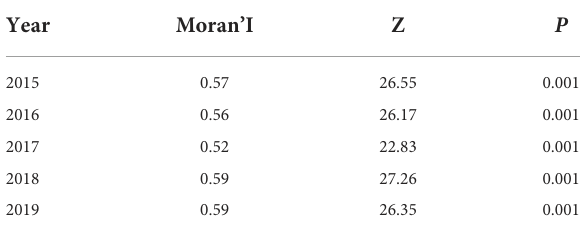
TABLE 2 Global spatial autocorrelation test.